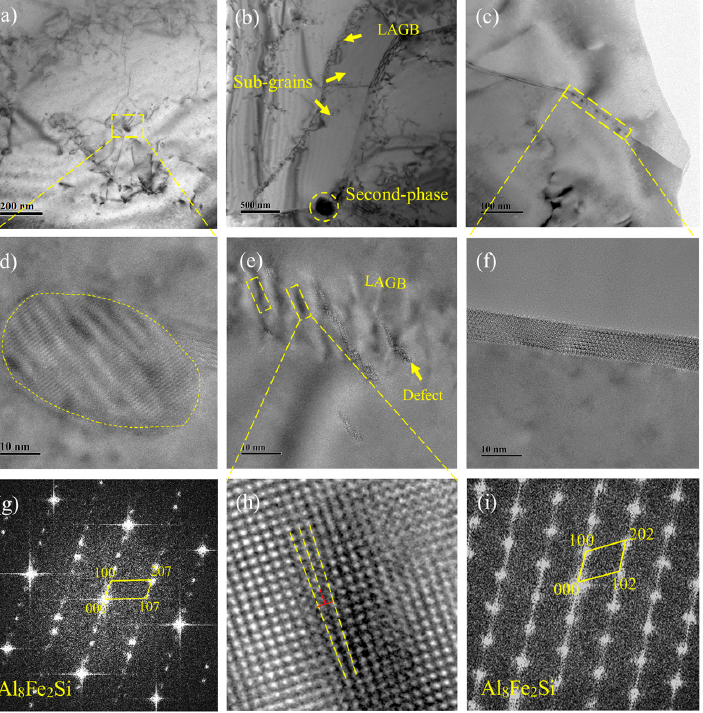
Figure 11. TEM images of the extruded alloy under different extrusion ratios: ( a , d , g ) λ = 7, ( b , e , h ) λ = 13, ( c , f , i ) λ = 30.